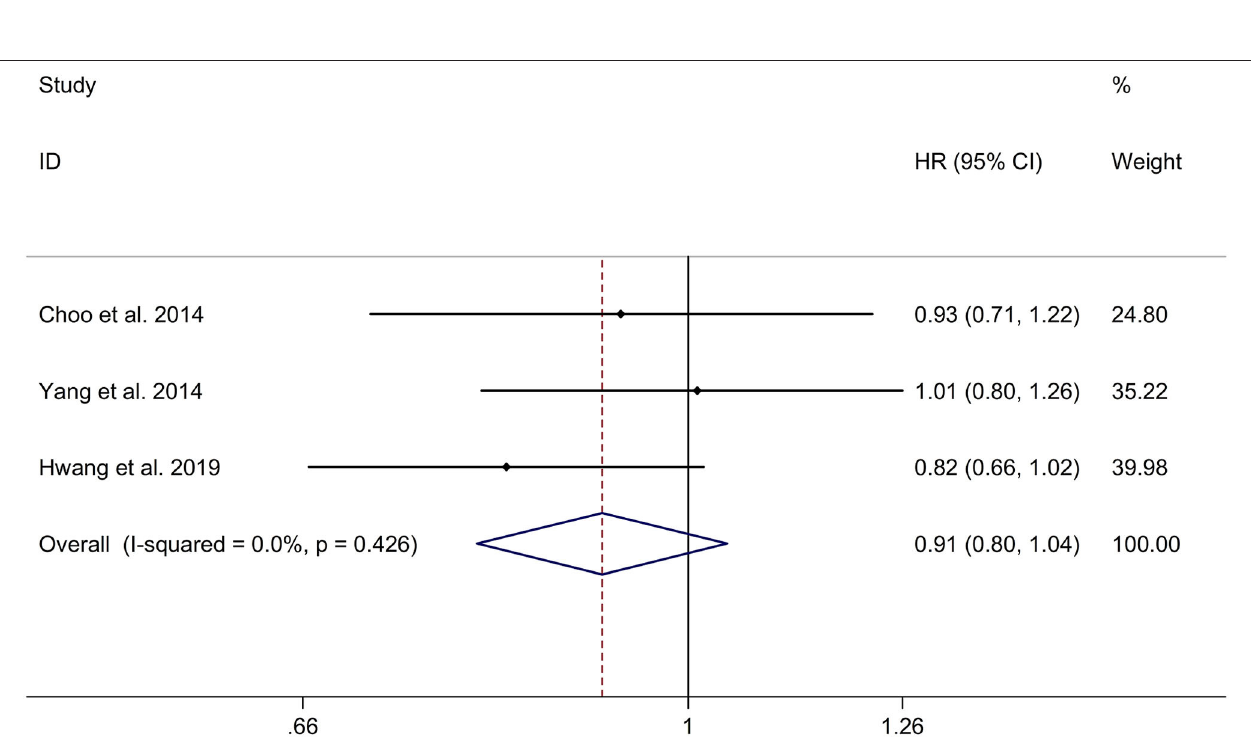
FIGURE 7 | Forest plots exploring the long-term effect of β -blocker use on risk of repeat revascularization in patients after MI. CIs, confidence intervals; HRs, hazard ratios; MI, myocardial infarction.